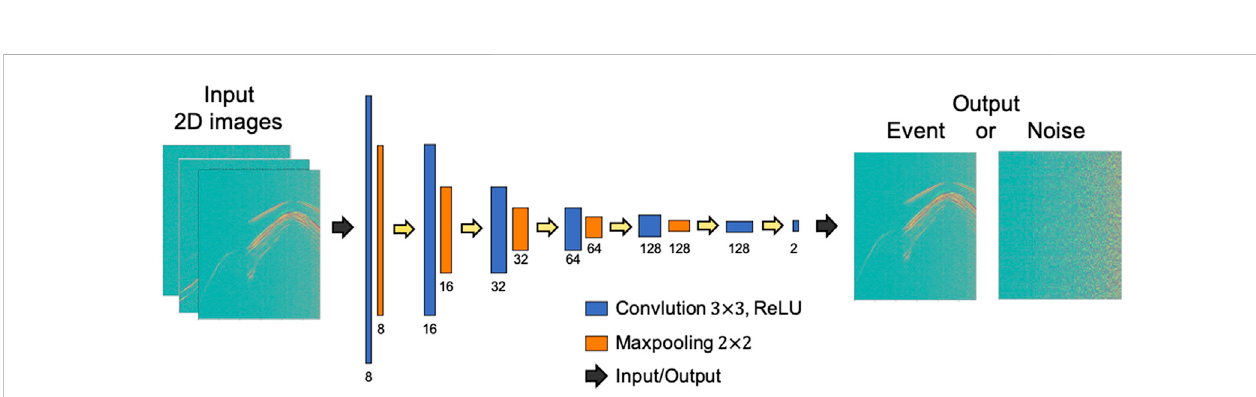
Frontiers in Earth